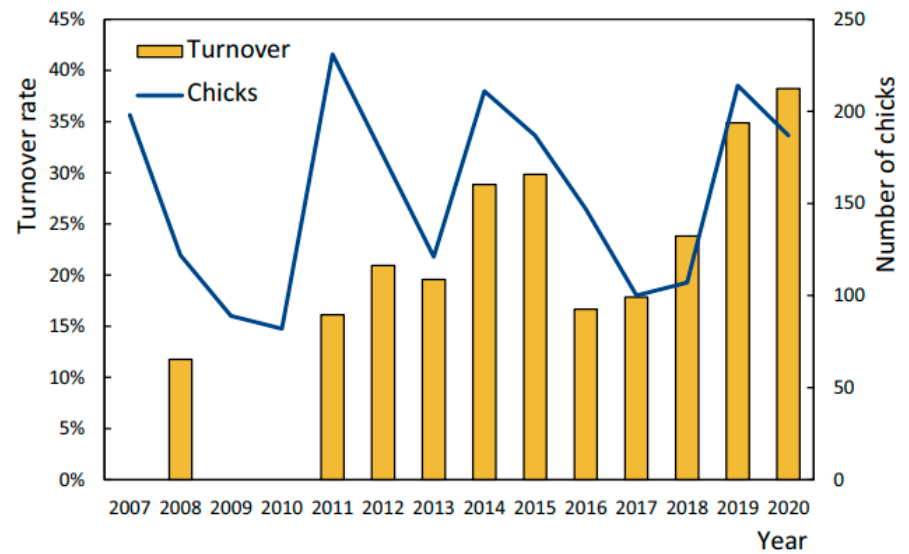
Figure 2. Turnover rate of parents each year, estimated from 11 microsatellite loci, as bars, and the actual number of chicks per year as a line.